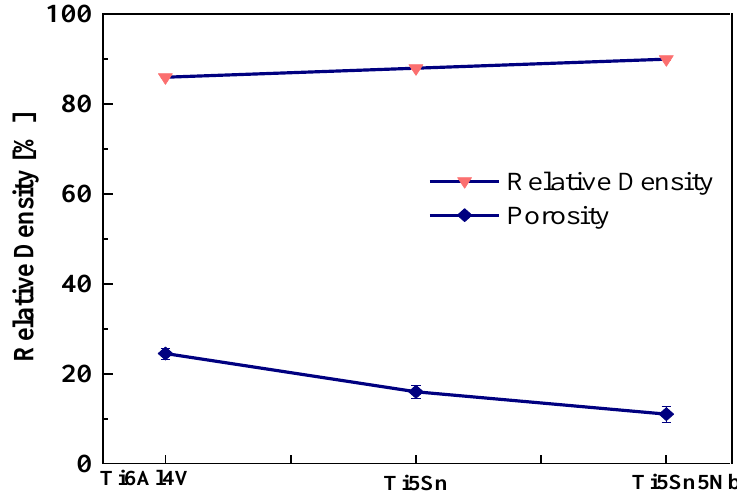
Figure 3. Relative density and porosity of Ti-based alloy. Upper line shows relative density, and lower line shows porosity.